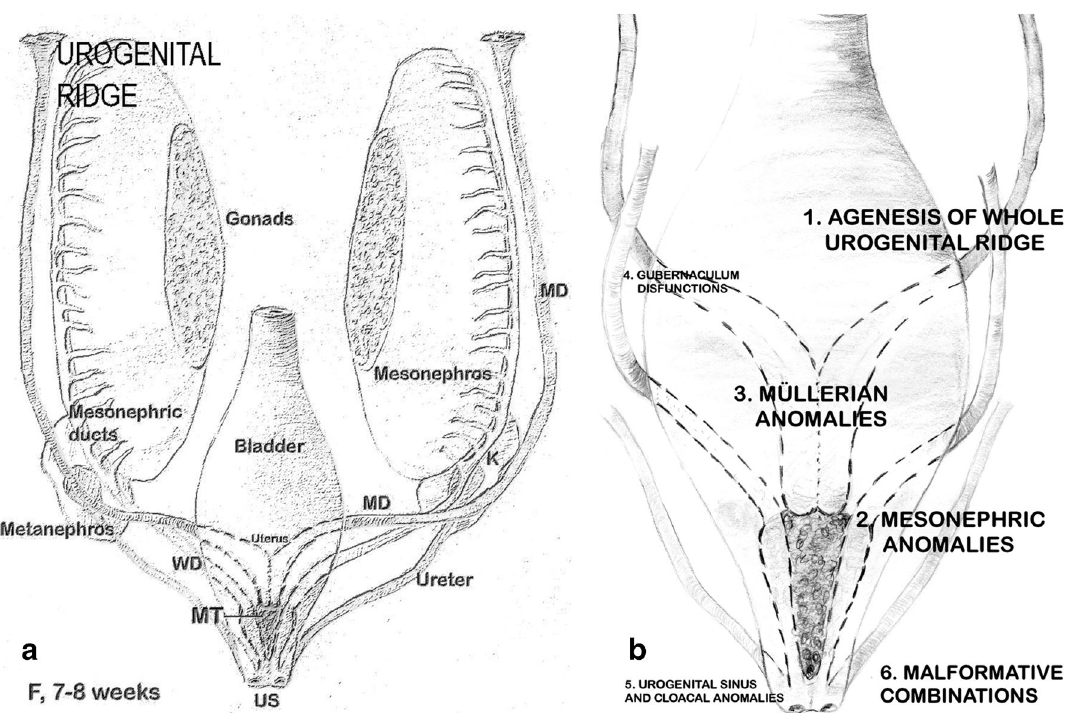
Fig. 1 Embryology of the female genito-urinary tract. a Development of the genital ducts inthefemale (frontalview, 7 – 8 weeks). Theformation of the uterine primordium and the opening of the mesonephric ducts into the urogenital sinus are shown. The Müllerian tubercle can be seen between both Wolffian ducts and the ureteral buds sprouting from the opening of the Wolffian duct into the urogenital sinus. MD, Müllerian ducts; WD,